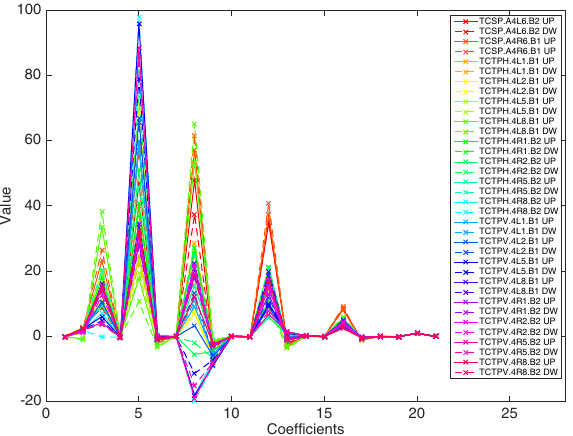
FIG. 13. The 2D fit coefficients c collimator BPMs during the collimator scans at flat top.